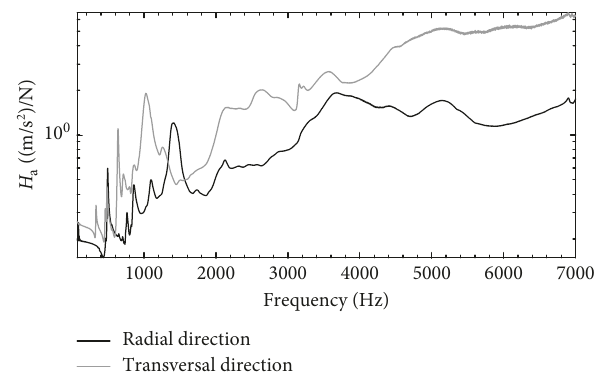
Figure 16: Sum of the FRFs for the two excitation references on the